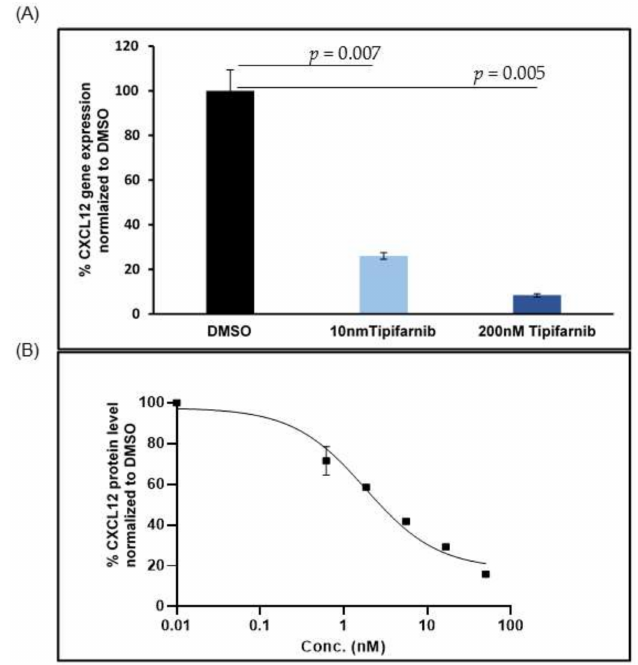
Figure 2. Tipifarnib inhibits CXCL12 expression in human pancreatic stellate cells. ( A ) Response of CXCL12 RNA level following 3 days of tipifarnib treatment as measured by quantitative PCR; ( B ) response of CXCL12 protein level to 3 days of tipifarnib treatment as measured by ELISA. Two-tailed t -test p values are depicted on the plots in ( A